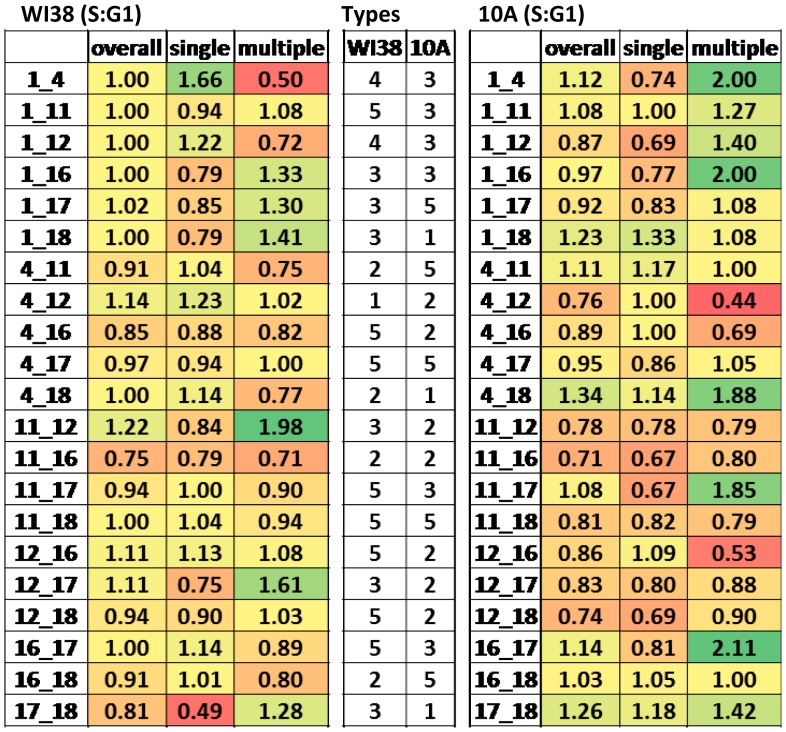
Alterations in interaction profiles from G1 to S phase.Calculation of the ratio between pairwise CT (S∶G1) reveals different alterations of CT interactions from G1 to S. Some alterations demonstrate an overall increase (type 1) in interaction while others have an overall decrease in interaction (type 2). Others switch from having greater levels with a singular interaction to those with more nuclei with multiple interactions (type 3) or vice versa (type 4). Others do not change from G1 to S (type 5). Values are color coded with green increasing the most from G1 to S and red decreasing the most. The types of alterations in interaction are displayed for WI38 and 10A in the center rows.